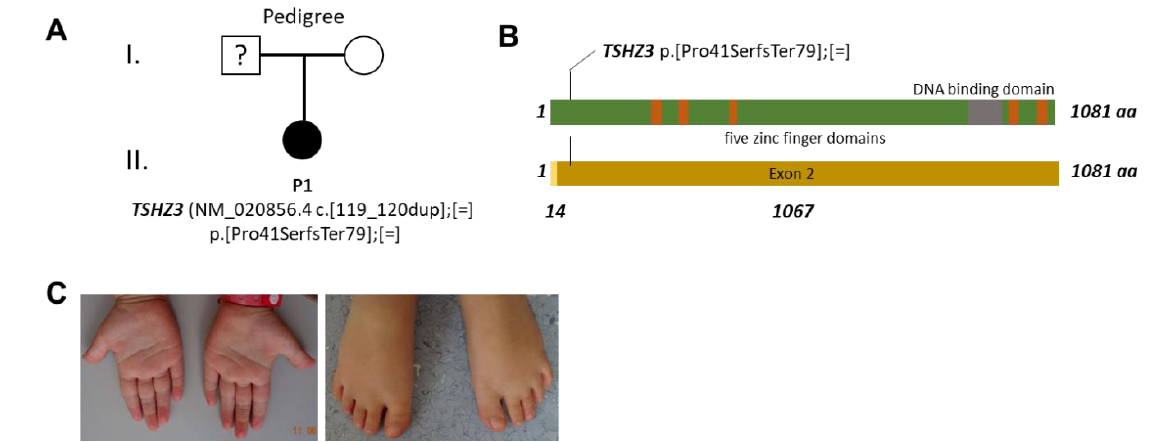
Figure 1. Pedigree, TSHZ3 domain architecture, variant position, and habitus of the affected indi- vidual. ( A ) Pedigree of the family of the affected individual. ( B ) TSHZ3 domain architecture. DNA binding domain = grey; zinc fingers = brown. ( C ) Clinical photos of the hands and feet of the affected individual at the age of 6.9 years. The participant and her parents provided written and informed consent for the taking and distribution of the photographs. The forms are stored in compliance with local confidentiality laws.